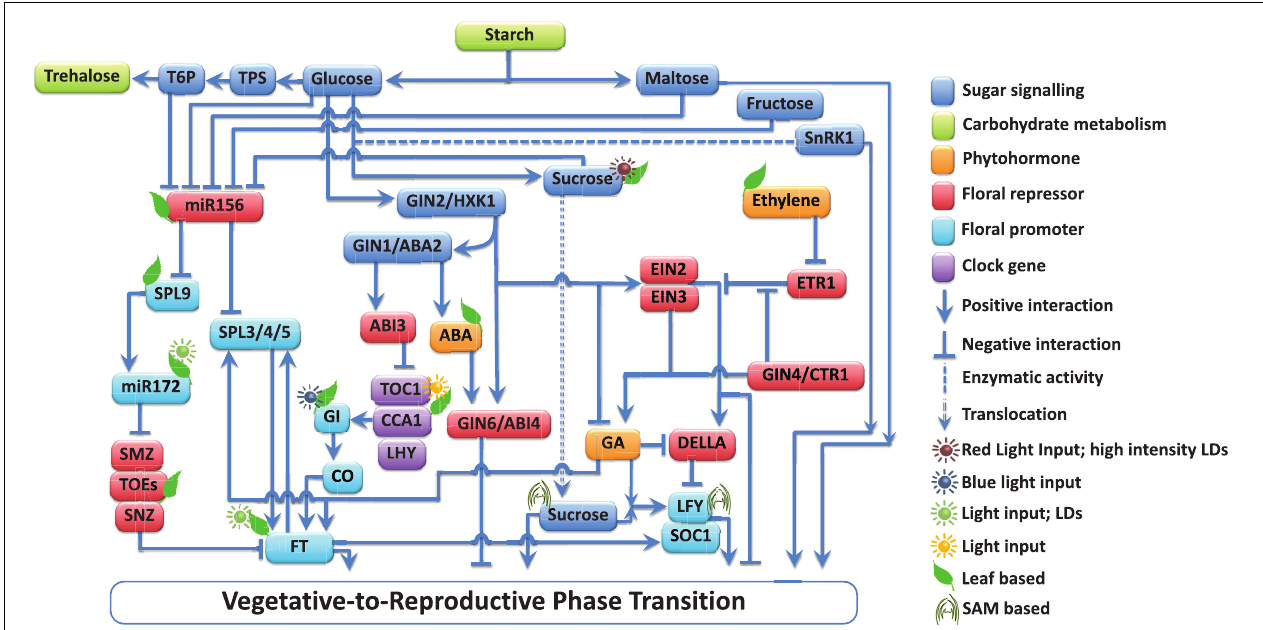
FIGURE 1 | Multiple interactions among the components involved in floral signal transduction in response to sugar-hormone interplay. Components of the pathways are grouped into those that promote ( ↓ ) and those that repress ( ⊥ ) floral signal transduction. Sugars affect the vegetative-to-reproductive phase transition through their function as energy sources, osmotic regulators, signaling molecules, and by their interaction with mineral and phytohormone networks (Ohto et al., 2001; Lloyd and Zakhleniuk, 2004; Matsoukas et al., 2013). Starch metabolism-related events have a key role in developmental phase transitions (Corbesier et al., 1998; Matsoukas et al., 2013). The actions of all pathways ultimately converge to control the expression of a small